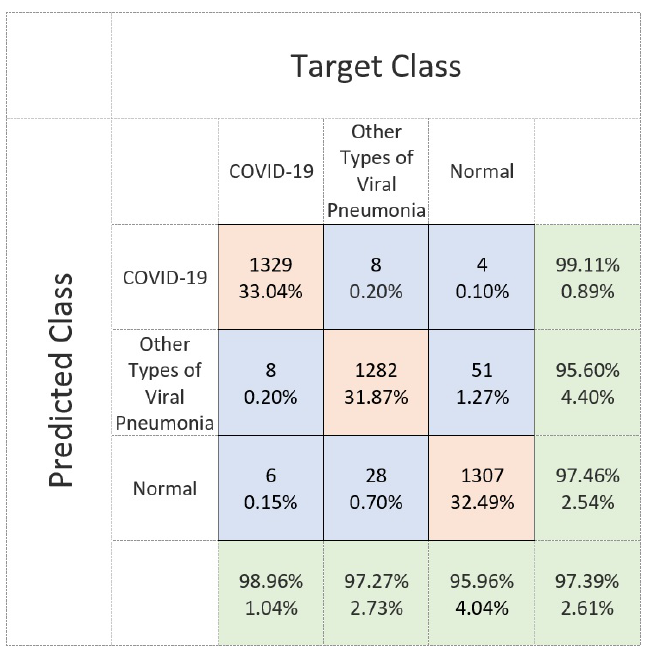
Figure 8. Confusion matrix performance of the Residual-Shuffle-Net in identifying the three classes of COVID-19, normal and other types of pneumonia cases using frontal chest X-ray images.